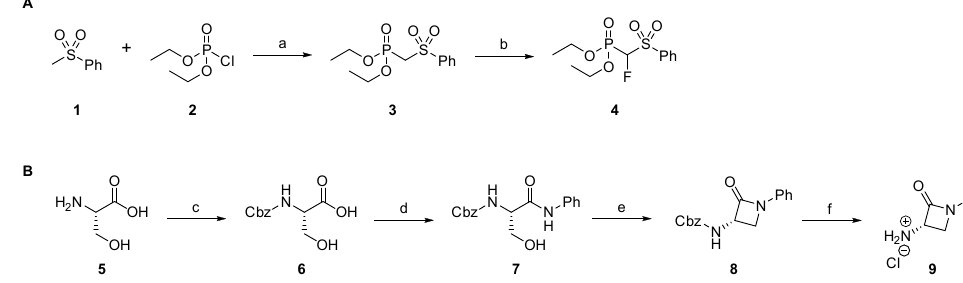
Scheme 1. Synthesis of precursor molecules. ( A ) Synthesis of phosphonate building block 4 . ( B ) Synthesis of β -Lactam building block 9 . Reaction conditions: (a) n -BuLi, DECP, THF, − 78 °C; (b) 3 ,